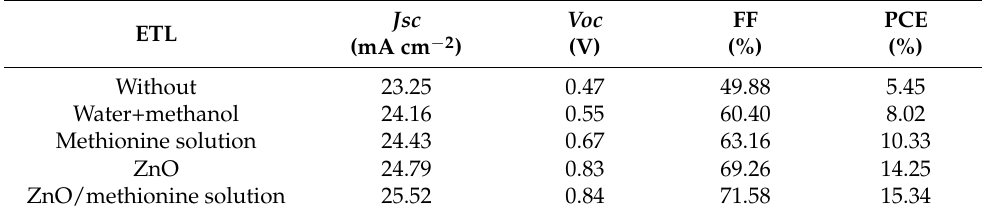
Figure 2. ( a ) J-V characteristic curves and ( b ) EQE spectra of OSCs with different ETLs. ( c ) Absorption spectra of different ETLs films and ( d ) different ETLs/active layer films. Table 1. Key photovoltaic parameters of OSCs with different ETLs.